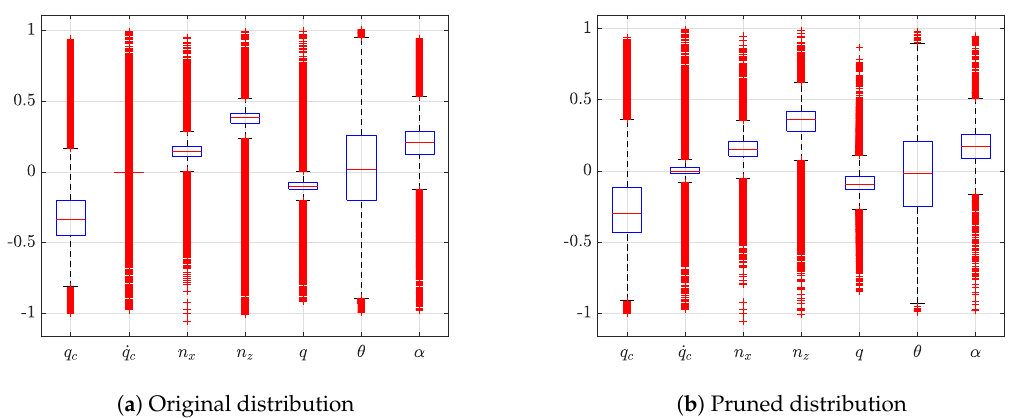
Figure 12. Comparison of hypercube normalized distribution on original training pattern and after Data-Driven Identification and Generation of Quasi-Steady States (DIGS) and Similar Flight Test Data Pruning (SFDP) method application. Global points are reduced from 980,191 to 27,318, outliers reduced from 48.9% to 18.8%.